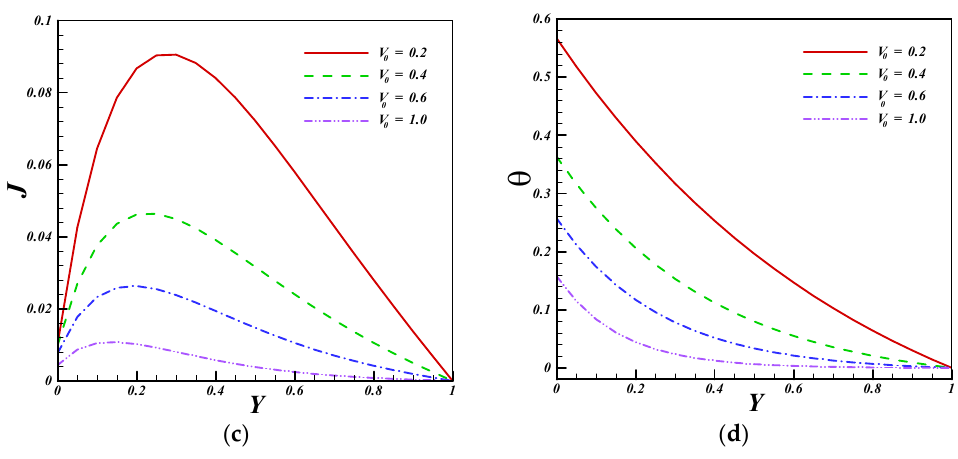
Figure 3. Effect of suction parameter on velocity ( U ); induced magnetic field (B ); induced current density ( J ) and induced temperature field ( θ ) distributions when Ha = 5, Pm = 1, φ = 0.04, Pr = 6.8.